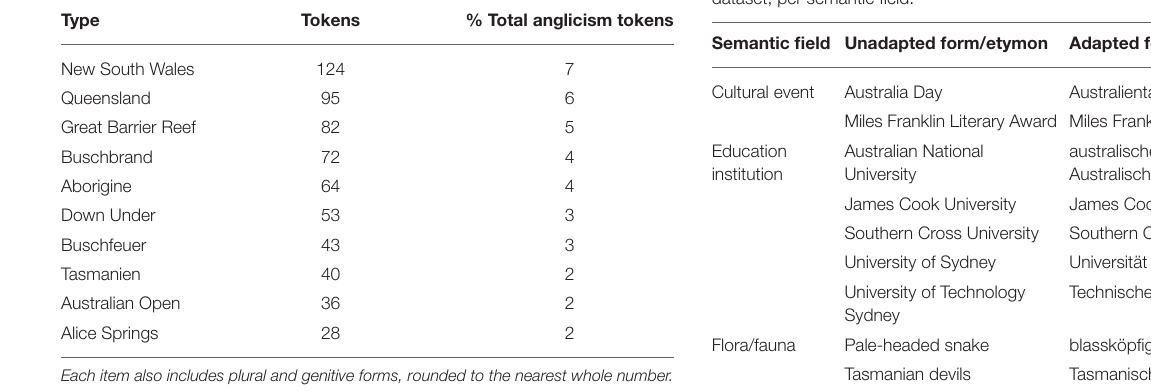
TABLE 2 | Ten most frequent anglicisms in the corpus.